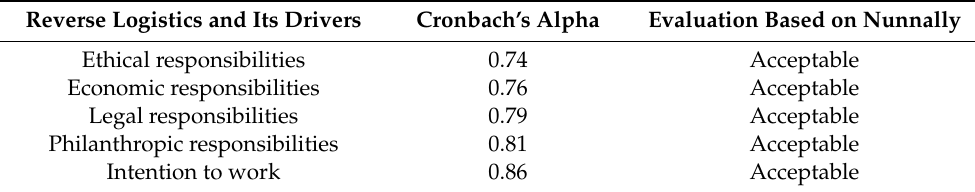
Table 2. Cronbach’s alpha coe ffi cients for dependent and independent variables.